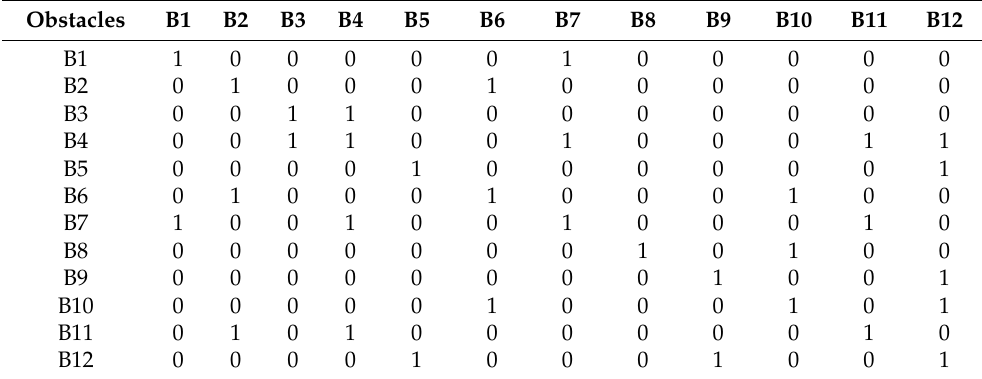
Table 8. Initial reachability matrix.